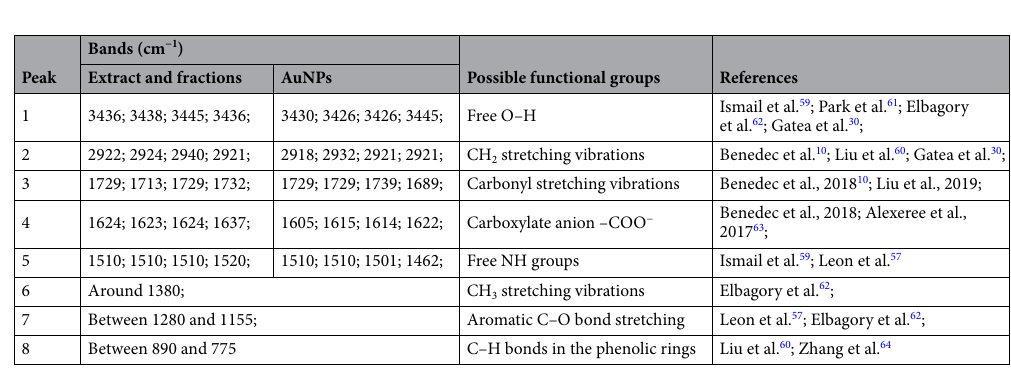
Table 2. Relation of the main peaks found in FTIR spectra of the BRP extract and its fraction and biosynthesized AuNPs.